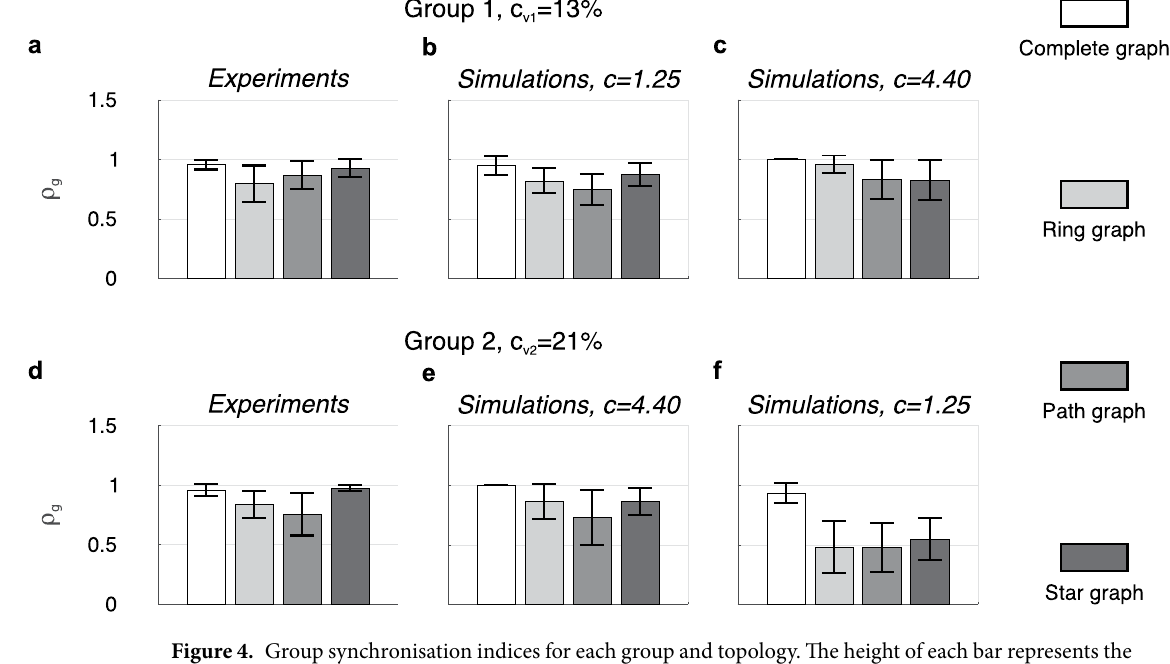
Figure 4. Group synchronisation indices for each group and topology. The height of each bar represents the mean value over time of ρ g ( t ) averaged over the total number of eyes-open trials, with different scales of grey referring to different topologies, whilst the black error bar represents its averaged standard deviation. The group synchronisation indices obtained experimentally across the four implemented topologies for Group 1 ( a ), which is characterised by a lower coefficient of variation = c 13% , are captured well numerically when c = 1.25 ( b ), v 1 while they are not when c = 4.40 ( c ). Analogously for Group 2 ( d ), which is characterised by a higher coefficient of variation = c 21% , they are captured well numerically when c = 4.40 ( e ), while they are not when c = 1.25 v 2 ( f